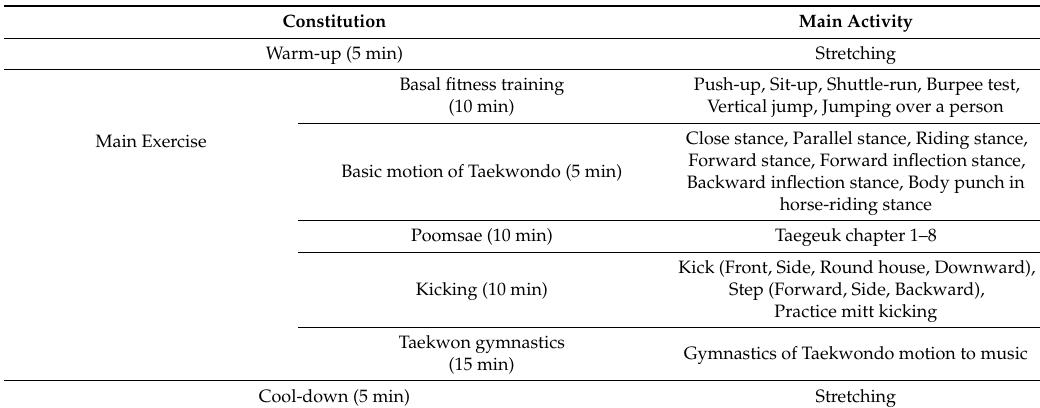
Table 2. Taekwondo training